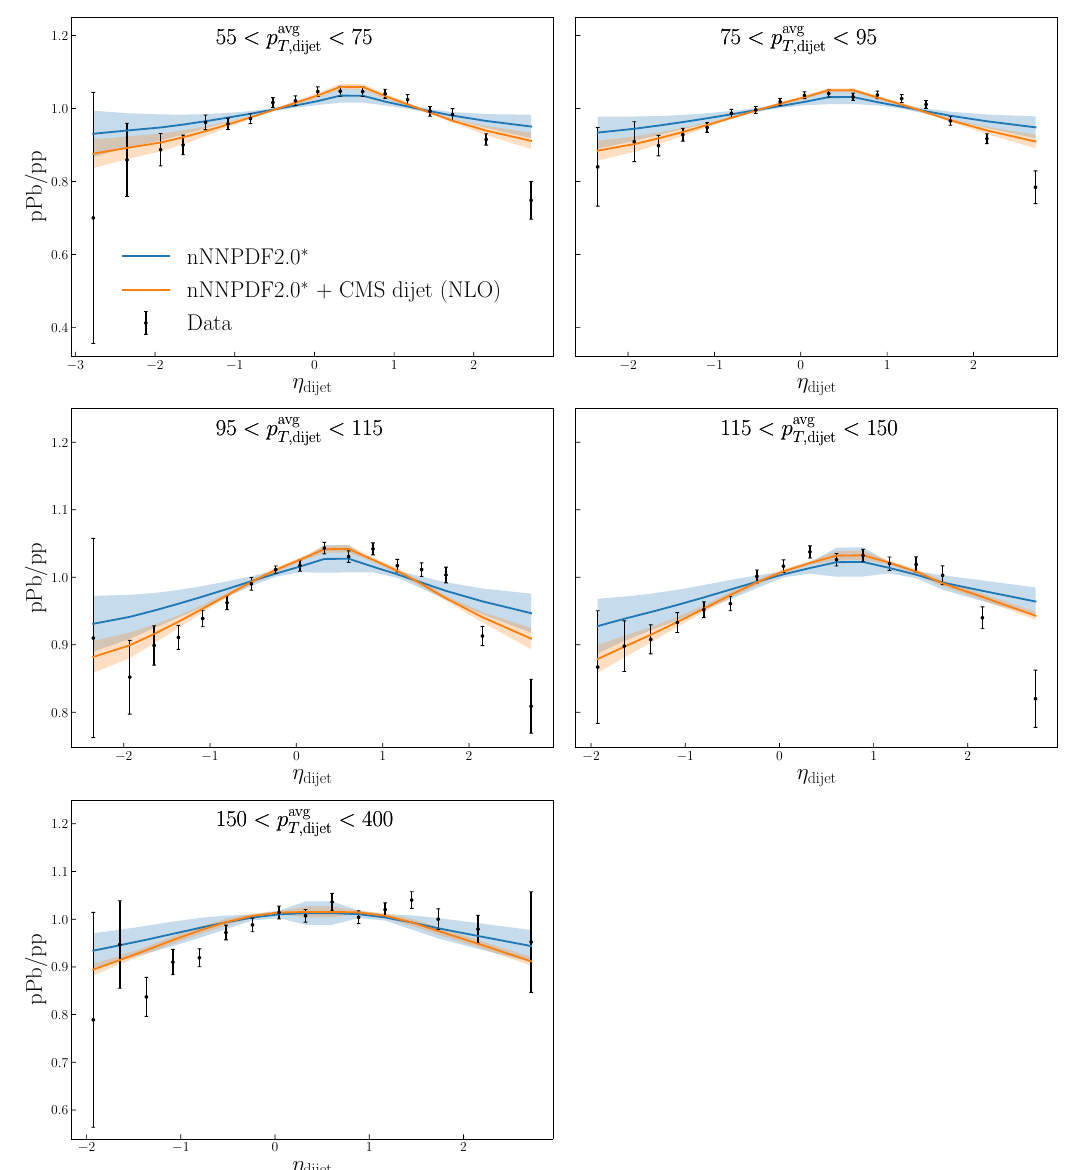
Figure 4: Comparison between the NLO theory predictions of the CMS dijet pPb / pp data from both (nNNPDF2.0 ∗ ) and (nNNPDF2.0 ∗ + CMS dijet) fits and the data for all bins of η and p avg dijet T ,dijet